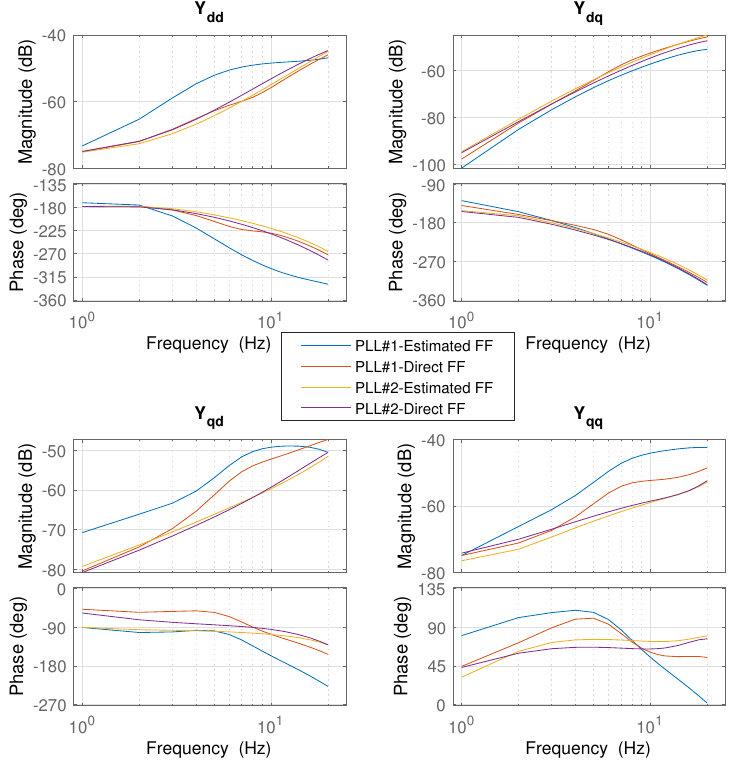
Figure 24. Traction chain input admittance. Frequency range: 1–20 Hz. Influence of the PLL and the feedforward.